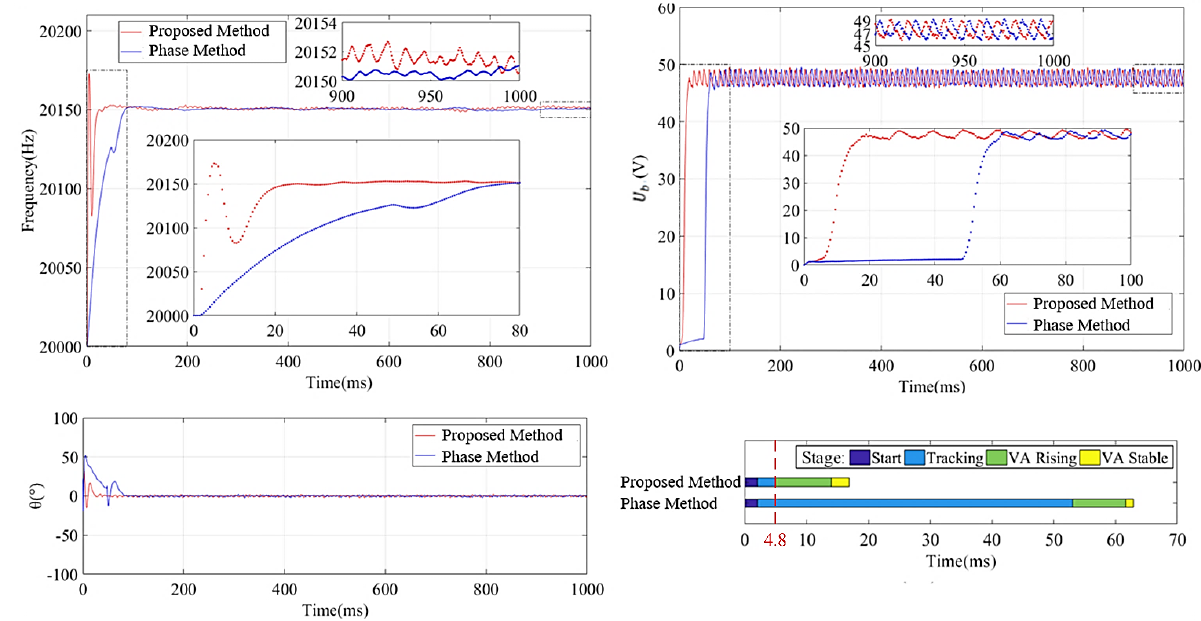
Figure 13. Comparison with the phase method under high and varying load condition.